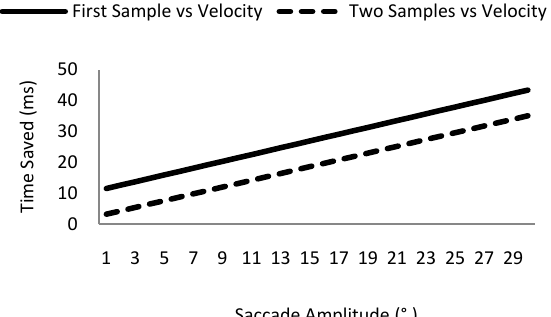
Figure 1. Amount of prediction time saved when First Sample and Two Samples models are compared to Velocity model Figure 1 indicates that prediction time saved amounts to 12 ms for First Sample model and 3 ms for Two Sam- ple model in case of 1° saccade. In case of 30° saccade the savings become 44 ms and 35 ms,